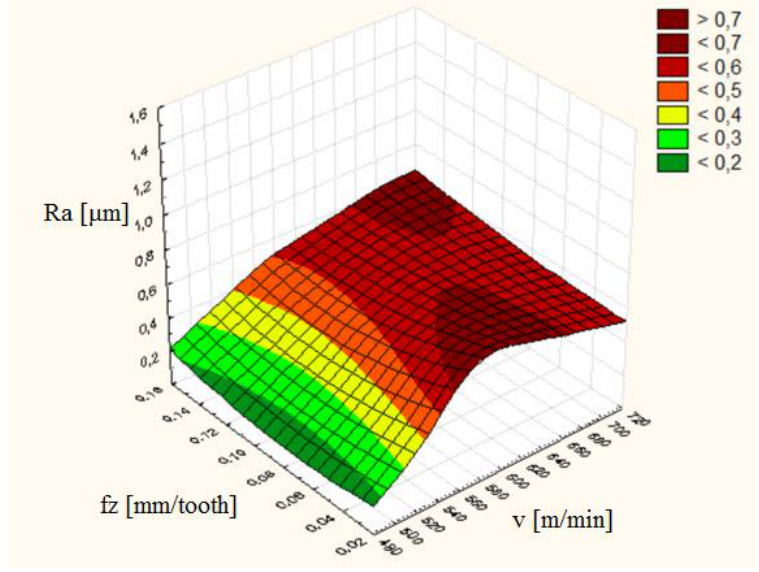
Figure 11. The spatial variation of R a according to v and f z .